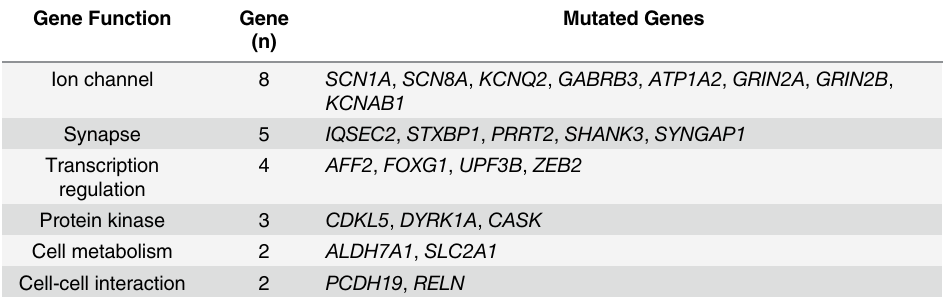
Table 2. The classification of mutated